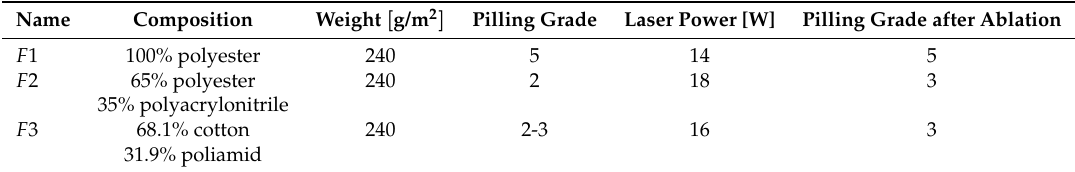
Table 1. Characteristics of knitwear samples used in abrasion tests. The pilling grade refers to materials after testing with a Martindale